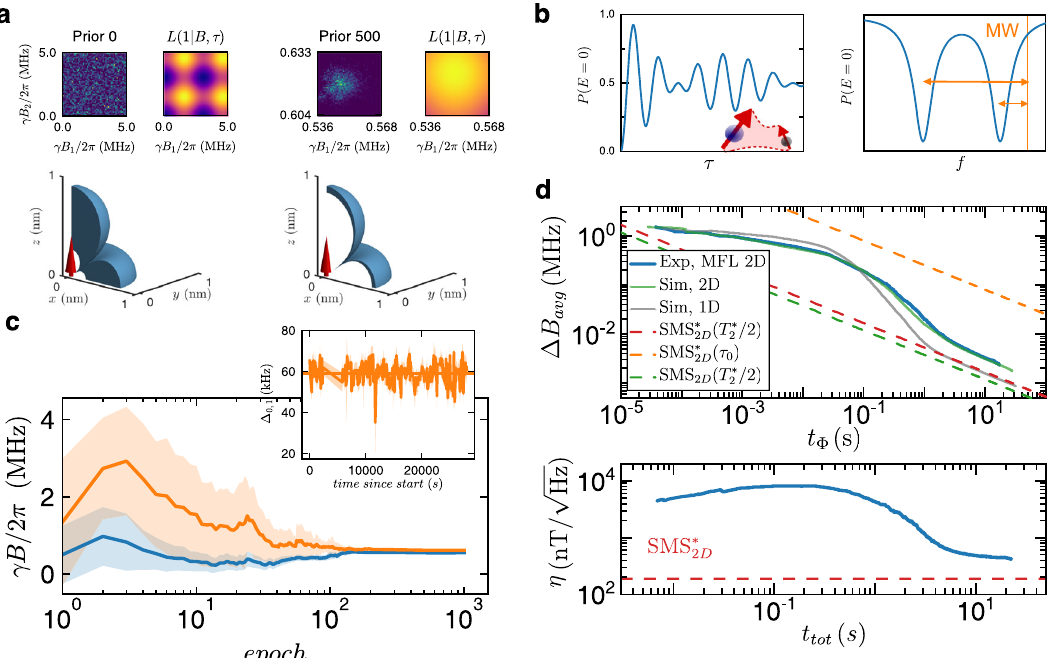
Fig. 3 Multiparameter estimation for determination of | A || |. a Exemplary (sampled) priors and likelihoods L (1| B , τ ) at epoch 0/500 of the 2D MFL run in ( c ). Bright color coding denotes a high probability. Below, the according fi rst quadrant of the 1 σ isosurfaces representing the possible position of the 13 C spin relative to the NV (NV e Z as a red arrow). The outer isosurface in epoch 0 is limited by the sensing volume to j A jj j > 1 = T (cid:3) 2 . b , Left: in the time domain, the result of a Ramsey sequence with a coupled single nuclear spin features two frequency components f 1,2 , each given by the offset from the driving microwave (MW) to the resonance of the spectrum in the frequency domain (right). c 2D MFL result estimating the two frequencies γ B 1 /2 π (blue), γ B 2 /2 π (orange) of the Ramsey fringe. Inset: difference Δ 0 ; 1 ¼ γ j B 2 (cid:2) B 1 j = 2 π of the fi nal estimate of subsequent MFL runs, each representing an estimated coupling j A jj j between NV and 13 C. The horizontal line is a fi t, yielding j A jj j = (59.10 ± 0.36) kHz. The mean uncertainty (s.d.) on γ B 1,2 /2 π of a single MFL run is σ B 1 ; 2 γ = 2 π ¼ 5 : 3kHz . d , Top: average uncertainty Δ B avg ¼ þ γσ B 2 Þ = 2 of the estimated fringe frequencies versus the accumulated phase evolution time t Φ of the 2D parameter estimation for 1000 ð γσ B 1 2 π 2 π epochs, n phot ~ 90, averaged over ~200 runs. For comparison, a simulation of a 1D estimation with same readout parameters ( C , n phot ) is ffiffiffiffiffiffi p (cid:2) 1 Hz shown. Bottom: corresponding sensitivity including overheads during the running time with a fi nal sensitivity of η 2D = 445 nT the magnetic fi eld uncertainty improves only with statistical ffiffiffiffiffi p t Φ / 1 = the average number of photons n phot in Supplementary Fig. 2a.